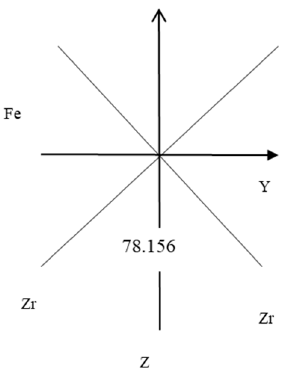
Figure 2. Projection of electric field gradient on chemical bond Fe-Zr.